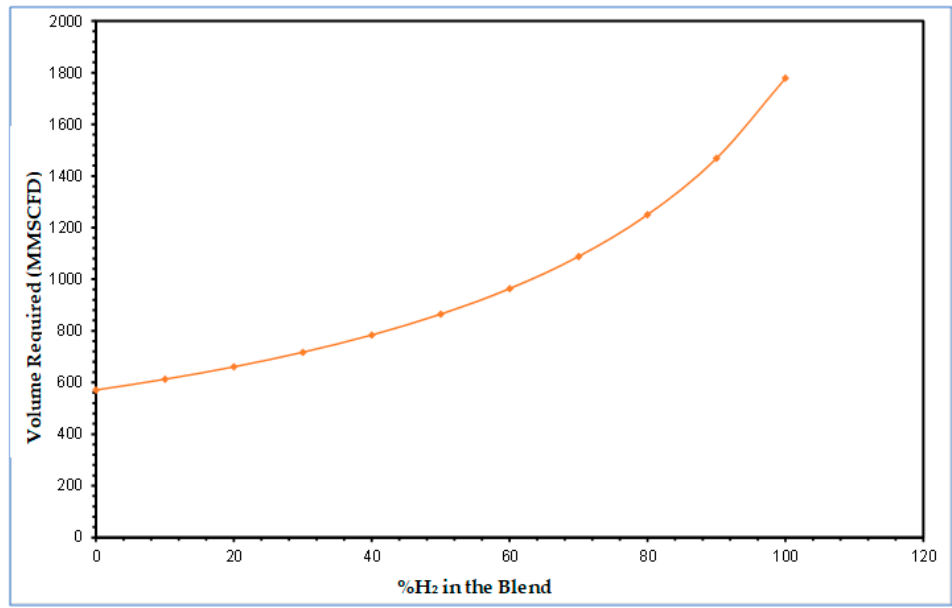
Figure 8. Volumetric requirements of natural gas and hydrogen for a constant supply of 6440 MW energy value (the intercept of the curve on the vertical axis indicates 100% natural gas).